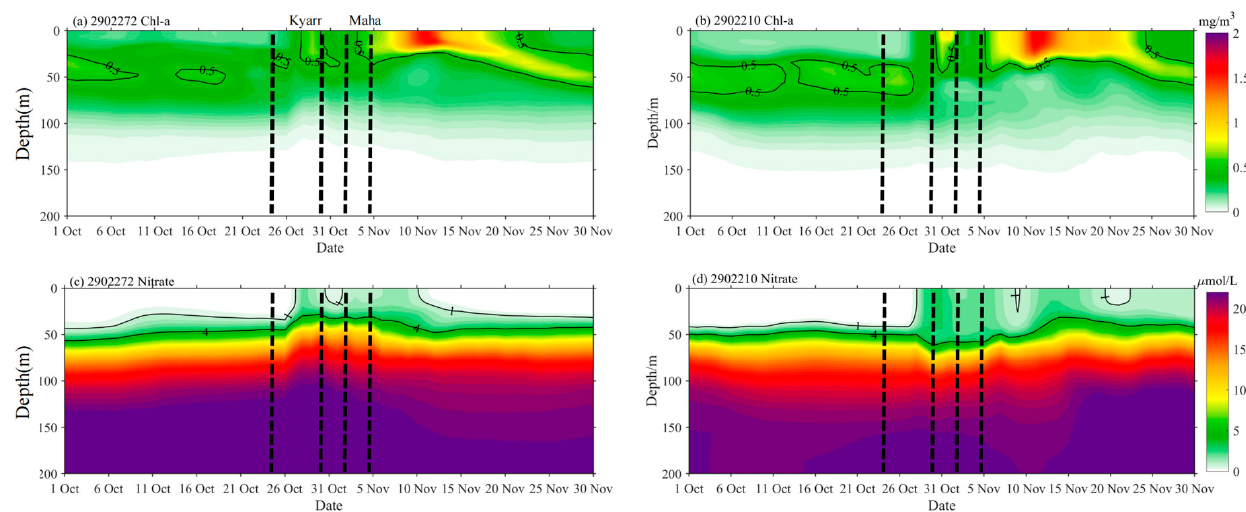
Figure 11. Time series of chl-a ( a , b ) and nitrate ( c , d ) concentrations based on the biogeochemistry model product in October and November in the areas of floats 2902272 and 2902210. Time is divided by four black lines into five periods (Pre-TC: before 25 October; During Kyarr: 26 October to 30 October; Post Kyarr: 1 November to 2 November; During Maha: 2 November to 5 November; Post Maha: after 5 November).